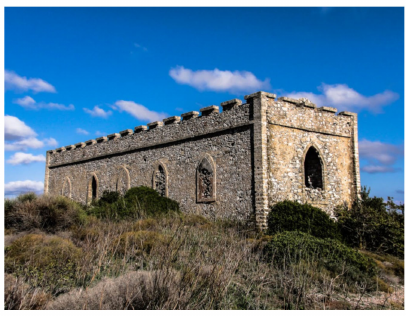
Figure 3. The English School of Milapidea in